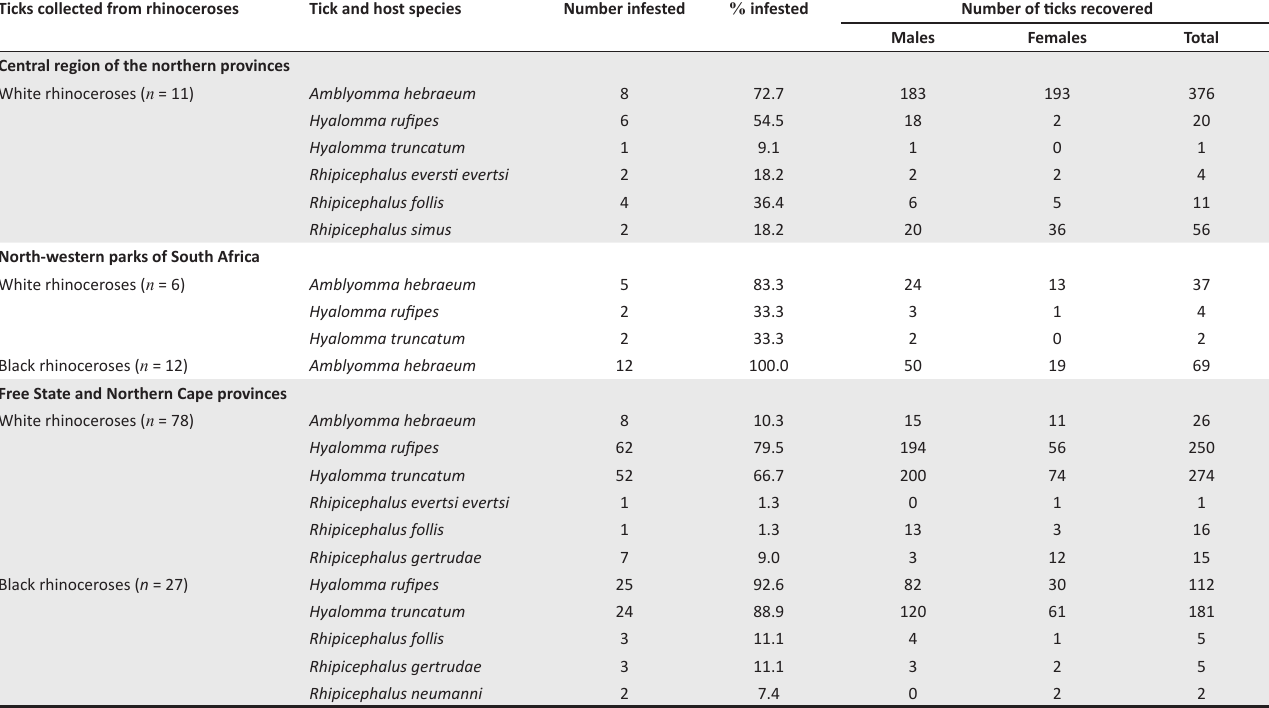
TABLE 3: Ixodid ticks collected from rhinoceroses in the Free State, Northern Cape province, north-western parks and central region of two northern provinces of South Africa. Ticks collected from rhinoceroses Central region of the northern provinces White rhinoceroses ( n = 11)